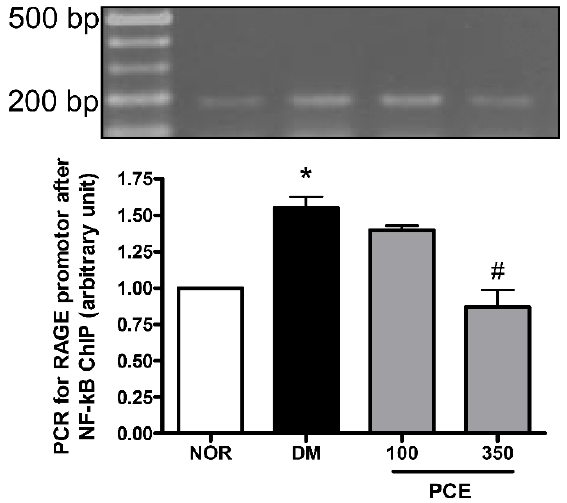
Figure 5. The effect of NF ‐κ B on RAGE promoter expression in the retina. ChIP was performed using an anti ‐ NF ‐κ B p65 antibody, and the RAGE promoter was amplified using RT ‐ PCR. The RT ‐ PCR products from a normal rat (NOR), an STZ ‐ induced diabetic rat (DM), a DM treated with 100 mg/kg PCE (PCE ‐ 100), and a DM treated with 350 mg/kg PCE (PCE ‐ 350) are shown. The PCR product size was 190 bp. The values in the bar graphs represent the mean ± SEM ( n = 8). * p < 0.01 vs. the NOR group and # p < 0.01 vs. the DM group.